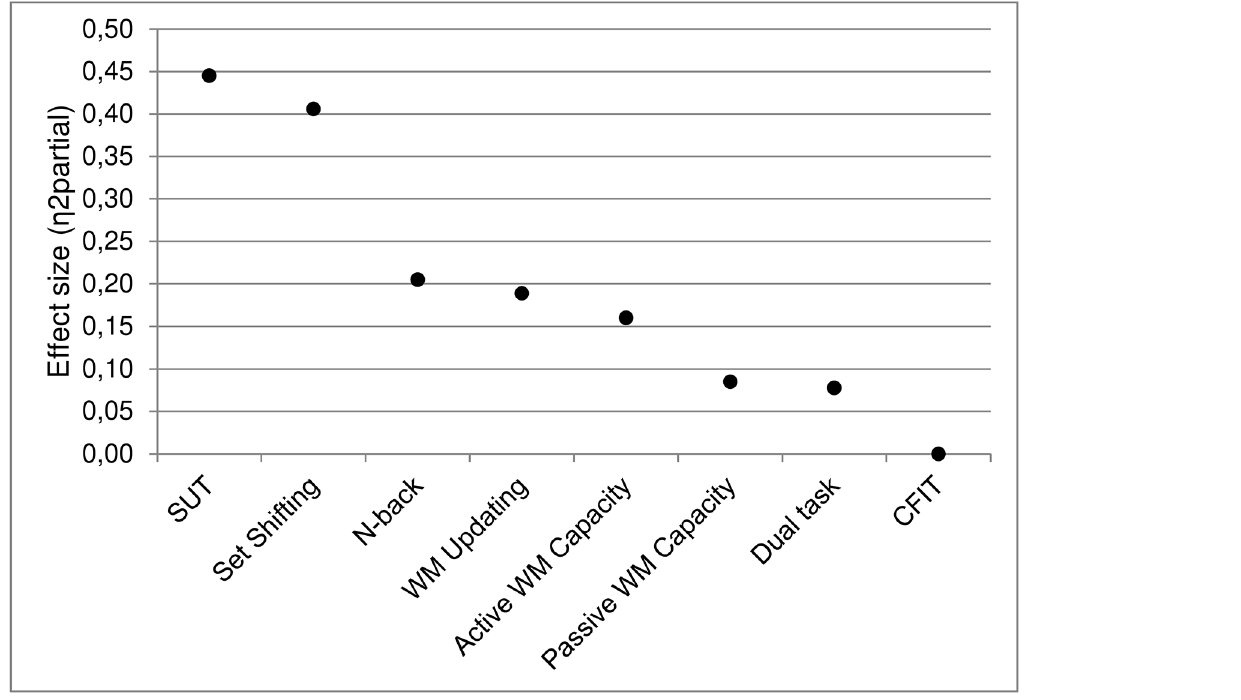
Fig 6. Graphical presentation of the outcome measure effect